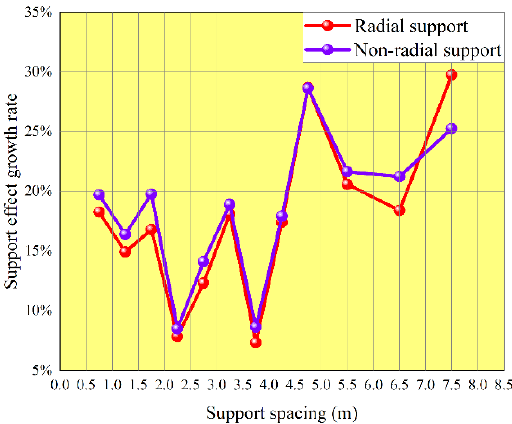
Figure 16. Support effect growth rate of the middle face under the two support schemes.